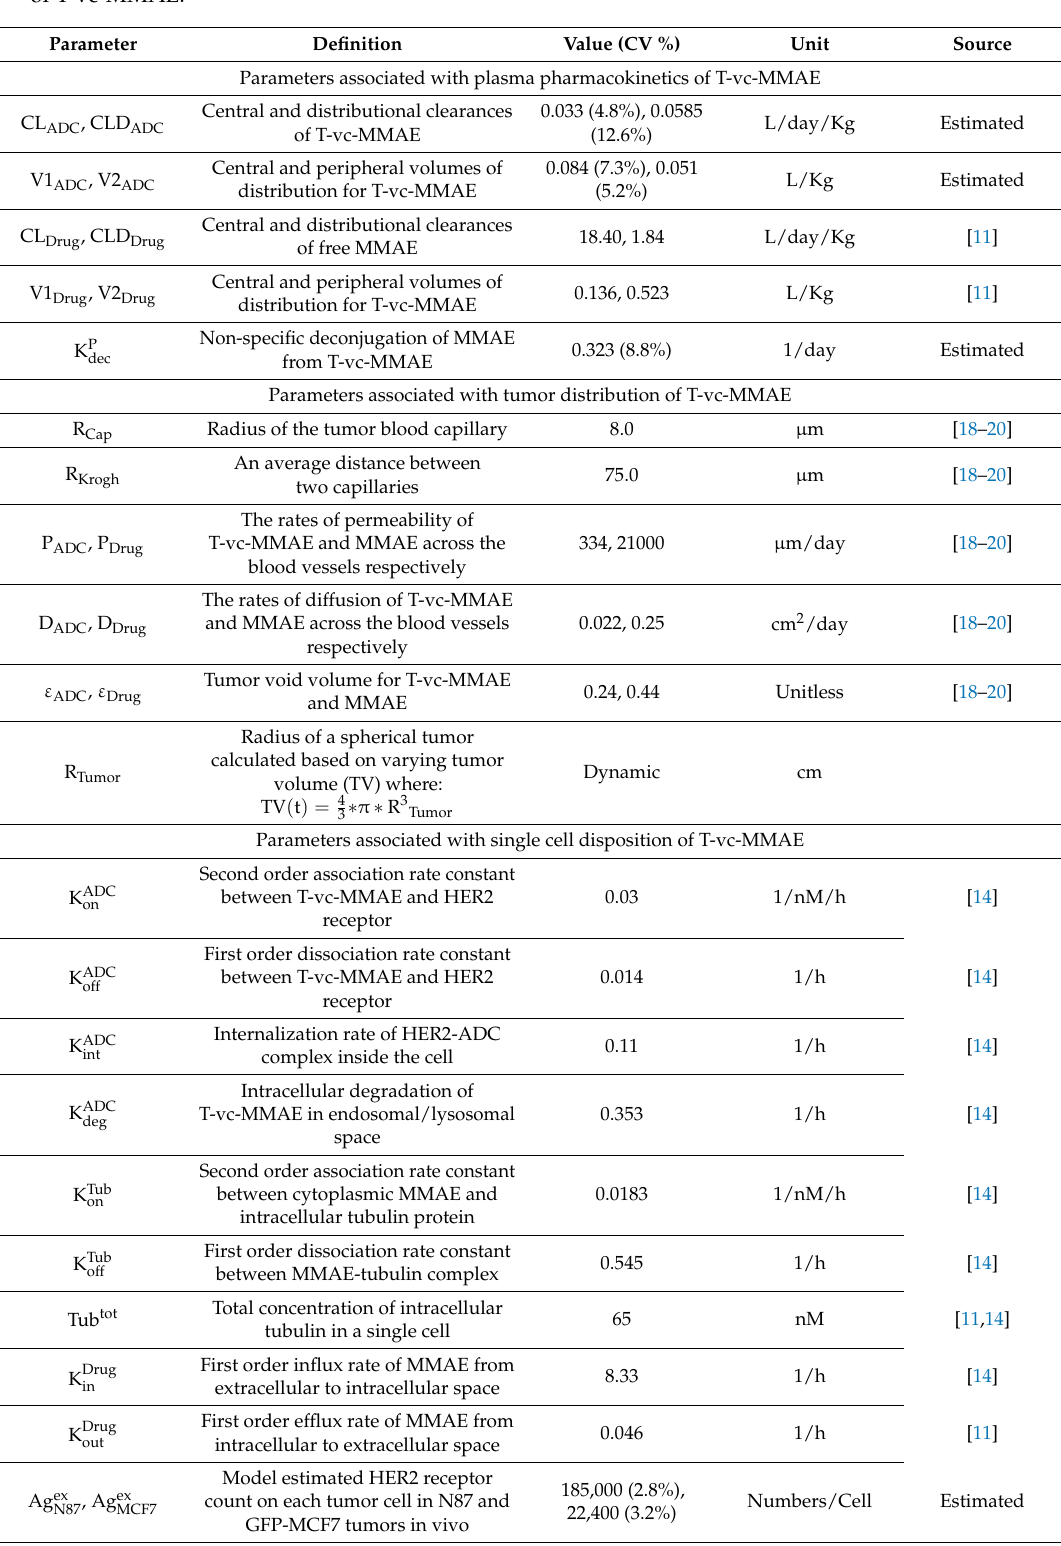
Table 1. A list of literature derived, or model estimated parameters used for the systems PK-PD model of